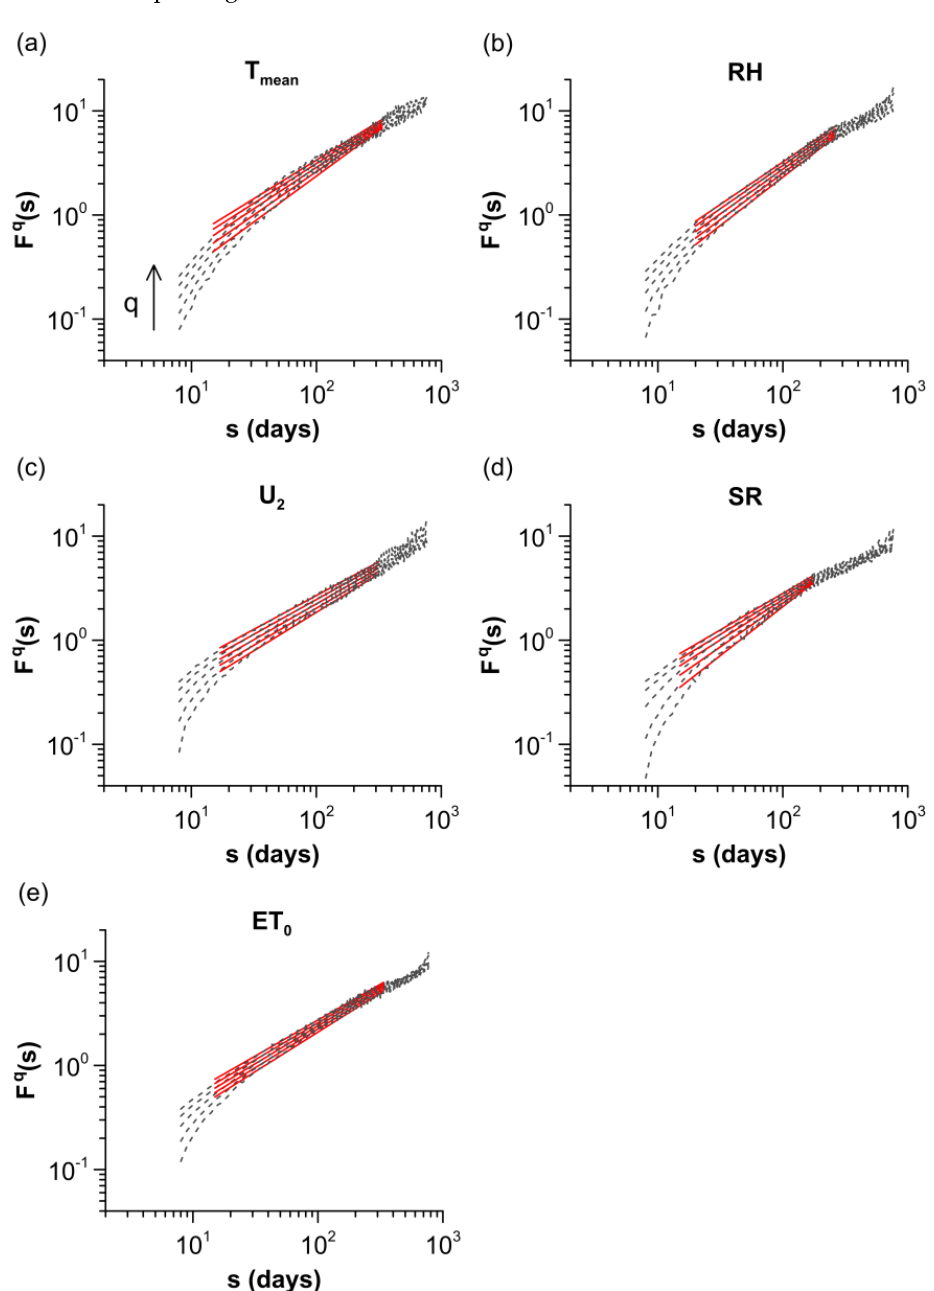
Figure 2. Detrended fluctuation functions 𝐹 𝑞 (𝑠) (gray dashed lines) with their linear fits (red solid lines). For reasons of clarity, only fluctuation functions and their fits for 𝑞 = [−4, −2, 0, 2,4] are displayed. ( a ) 𝑇 𝑚𝑒𝑎𝑛 . ( b ) 𝑅𝐻 . ( c ) 𝑈 2 . ( d ) 𝑆𝑅 . ( e ) 𝐸𝑇 0 .